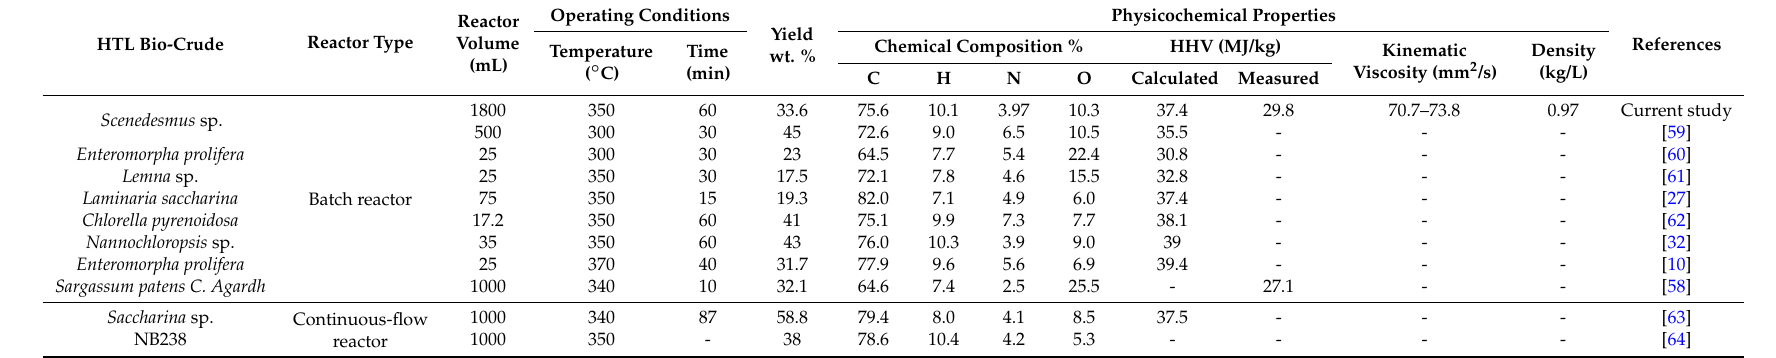
Table 6. Comparison of results from this study with